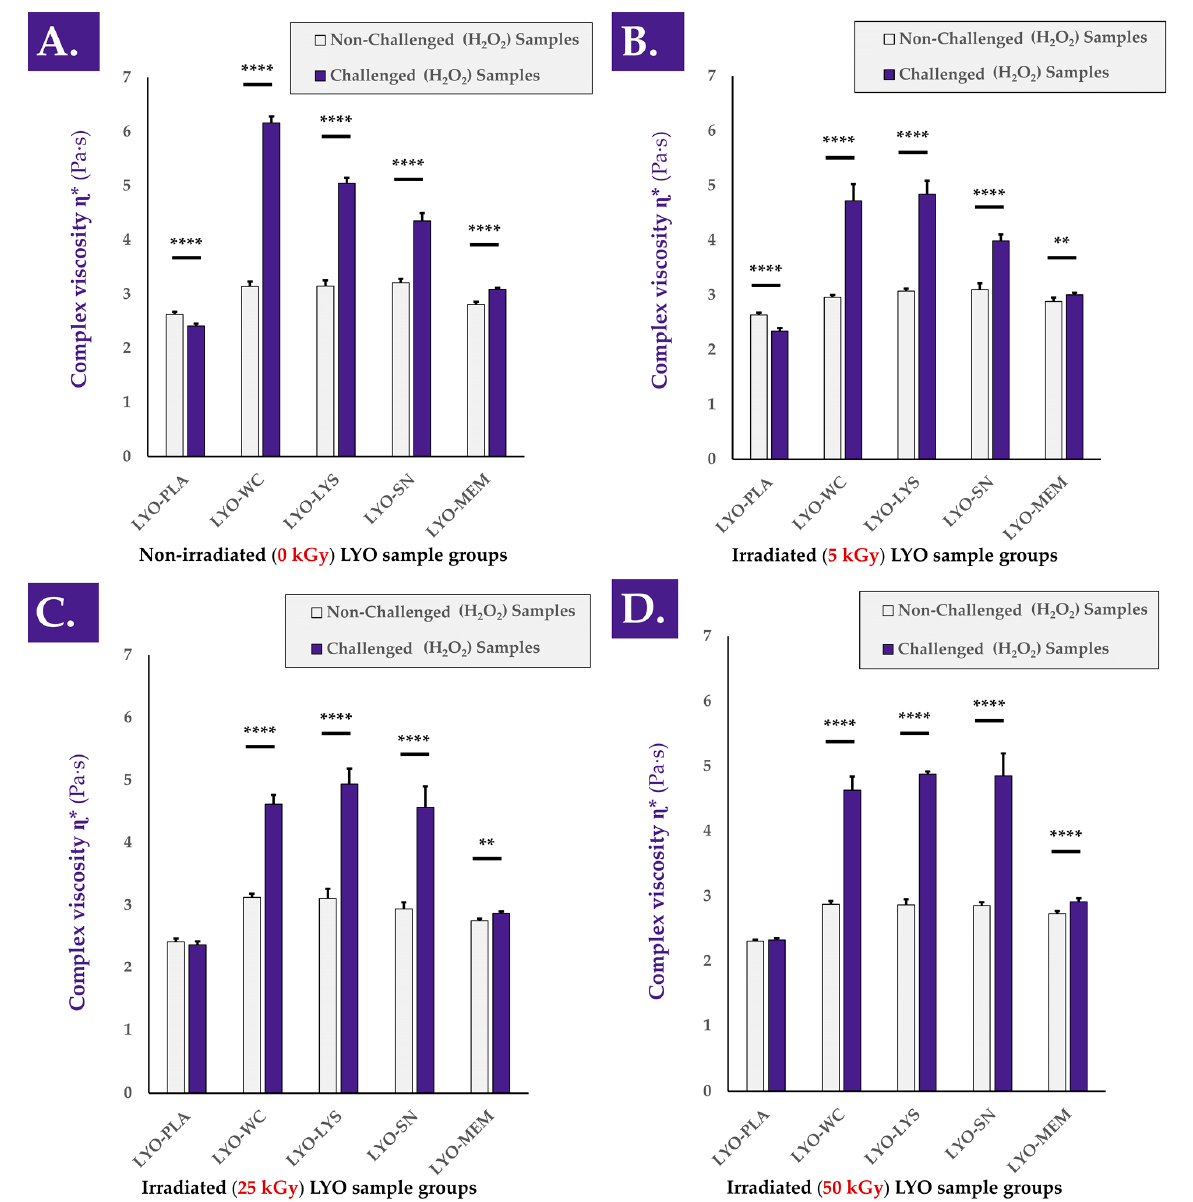
Figure 3. Complex viscosity η * of reconstituted (i.e., in a hydrogel of HA 2.2–2.4 MDa MW at 1% in H 2 O:PBS 1:1) non-irradiated ( A ) or γ -irradiated (5 kGy, ( B ); 25 kGy, ( C ); 50 kGy, ( D )) progenitor tenocyte extracts, with the placebo controls. Each sample was analyzed following H 2 O 2 challenge or PBS addition (i.e., internal non-challenged controls). Very significant (i.e., ** or 0.001 < p value < 0.01) or extremely significant (i.e., **** or p value < 0.0001) differences were found between the sample mean values. HA, hyaluronic acid; kGy, kiloGray; LYO-PLA, lyophilized placebo sample; LYO-LYS, lyophilized lysate fraction; LYO-MEM, lyophilized membrane fraction; LYO-SN, lyophilized solu- ble fraction; LYO-WC, lyophilized whole-cell fraction; MDa, megaDaltons; MW, molecular weight; Pa · s, Pascal seconds; PBS, phosphate-buffered saline.